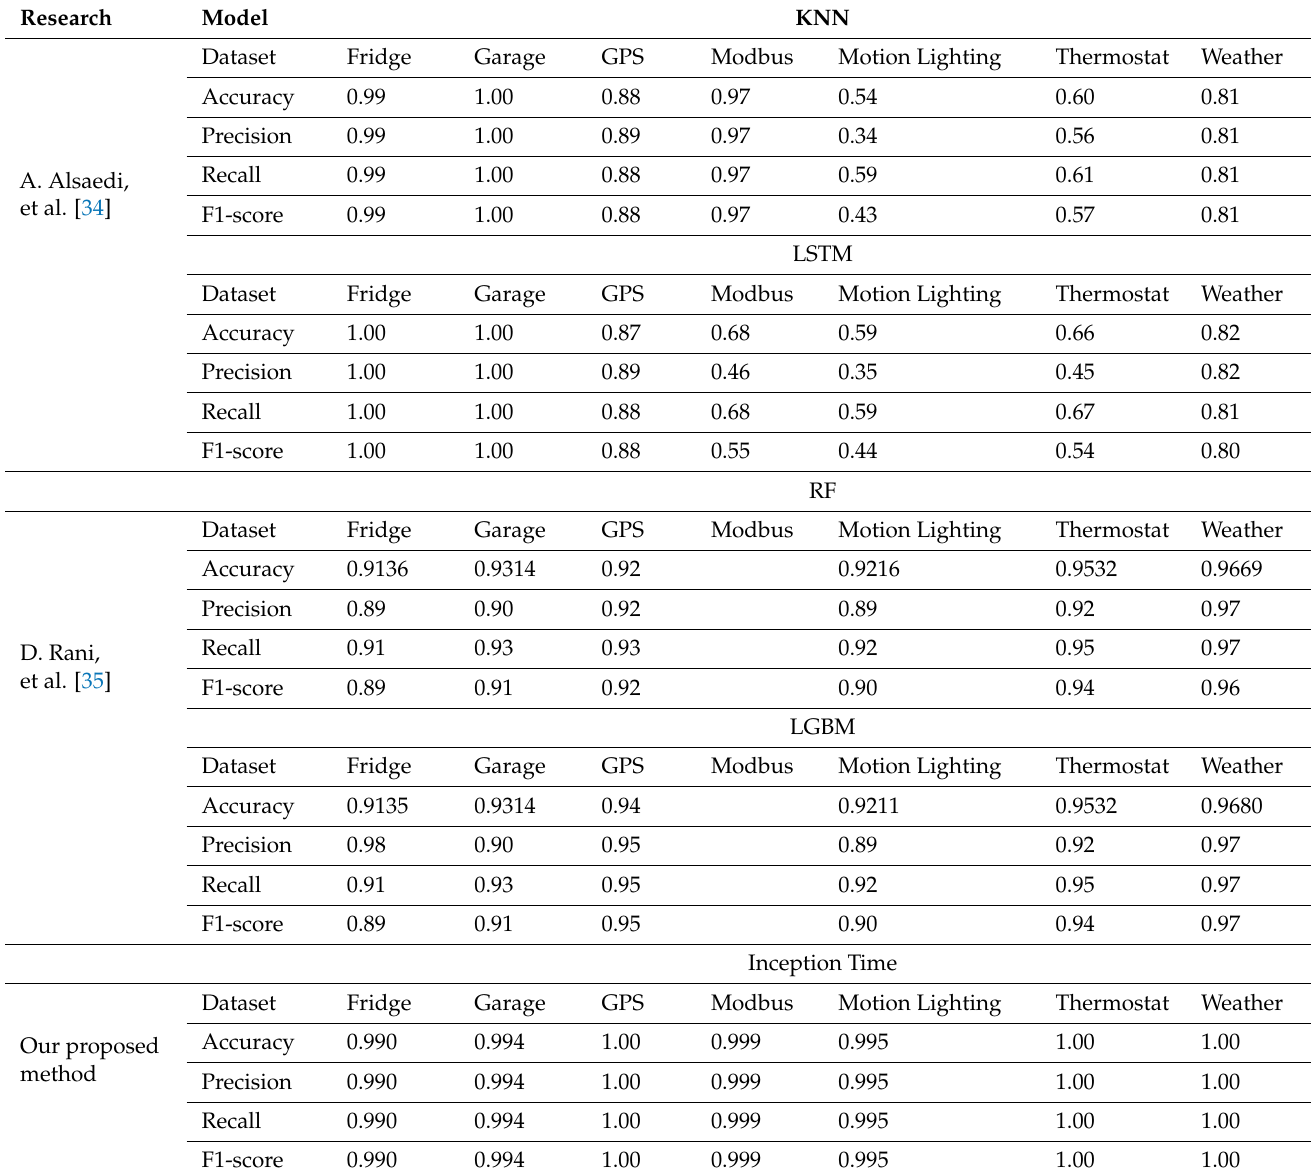
Table 8. Comparison of the results of previous studies using the IoT devices in the ToN-IoT